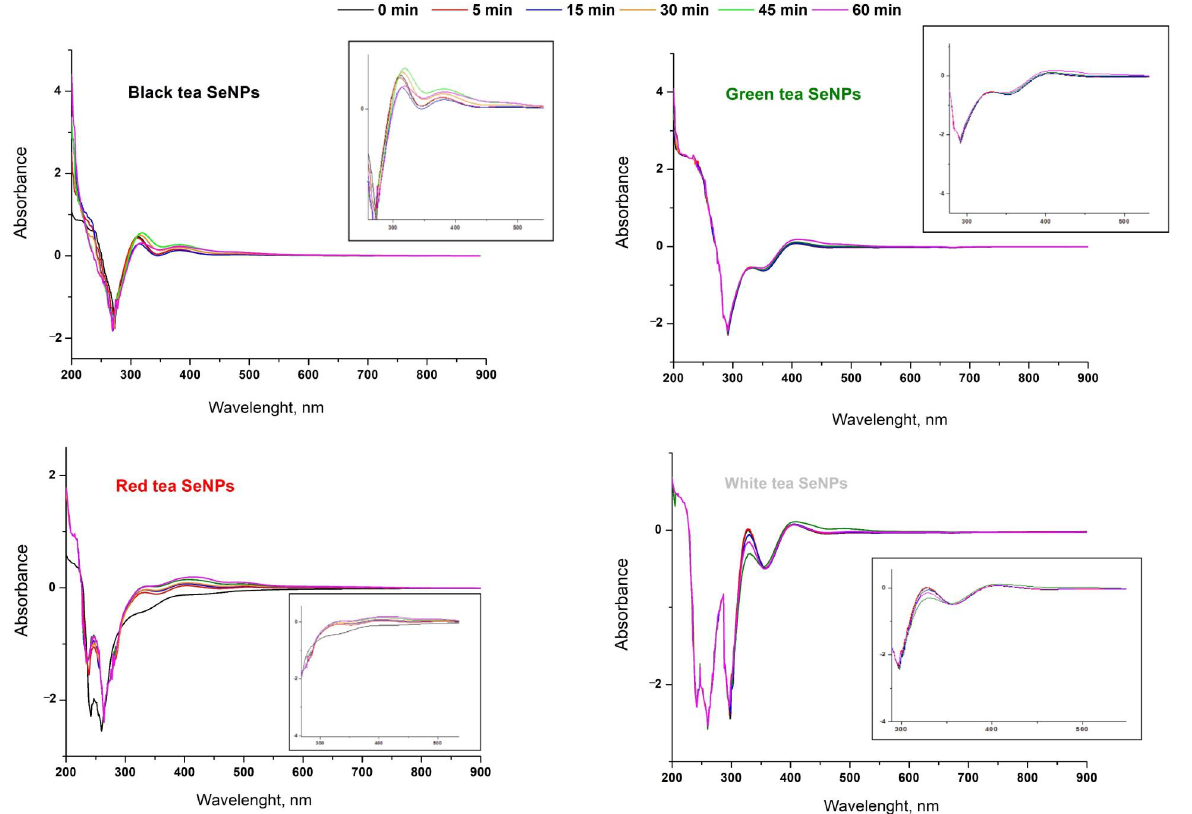
Figure 2. The UV-Vis spectra of selenium particles as a function of synthesis time. The box on each graph is an approximation of the 300–500 nm region.